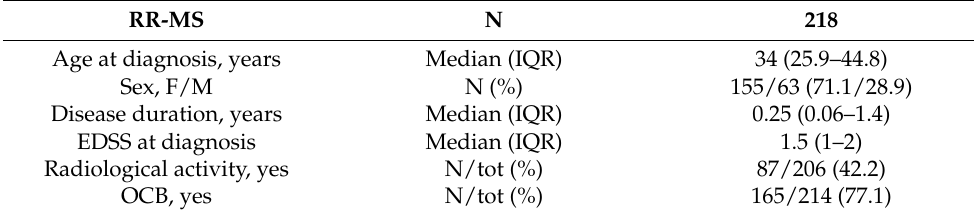
Table 1 Legend: expanded disability status scale (EDSS); female (F); interquartile range (IQR); male (M); multiple sclerosis (MS); number (N); oligoclonal bands (OCB); Relapsing–remitting (RR).